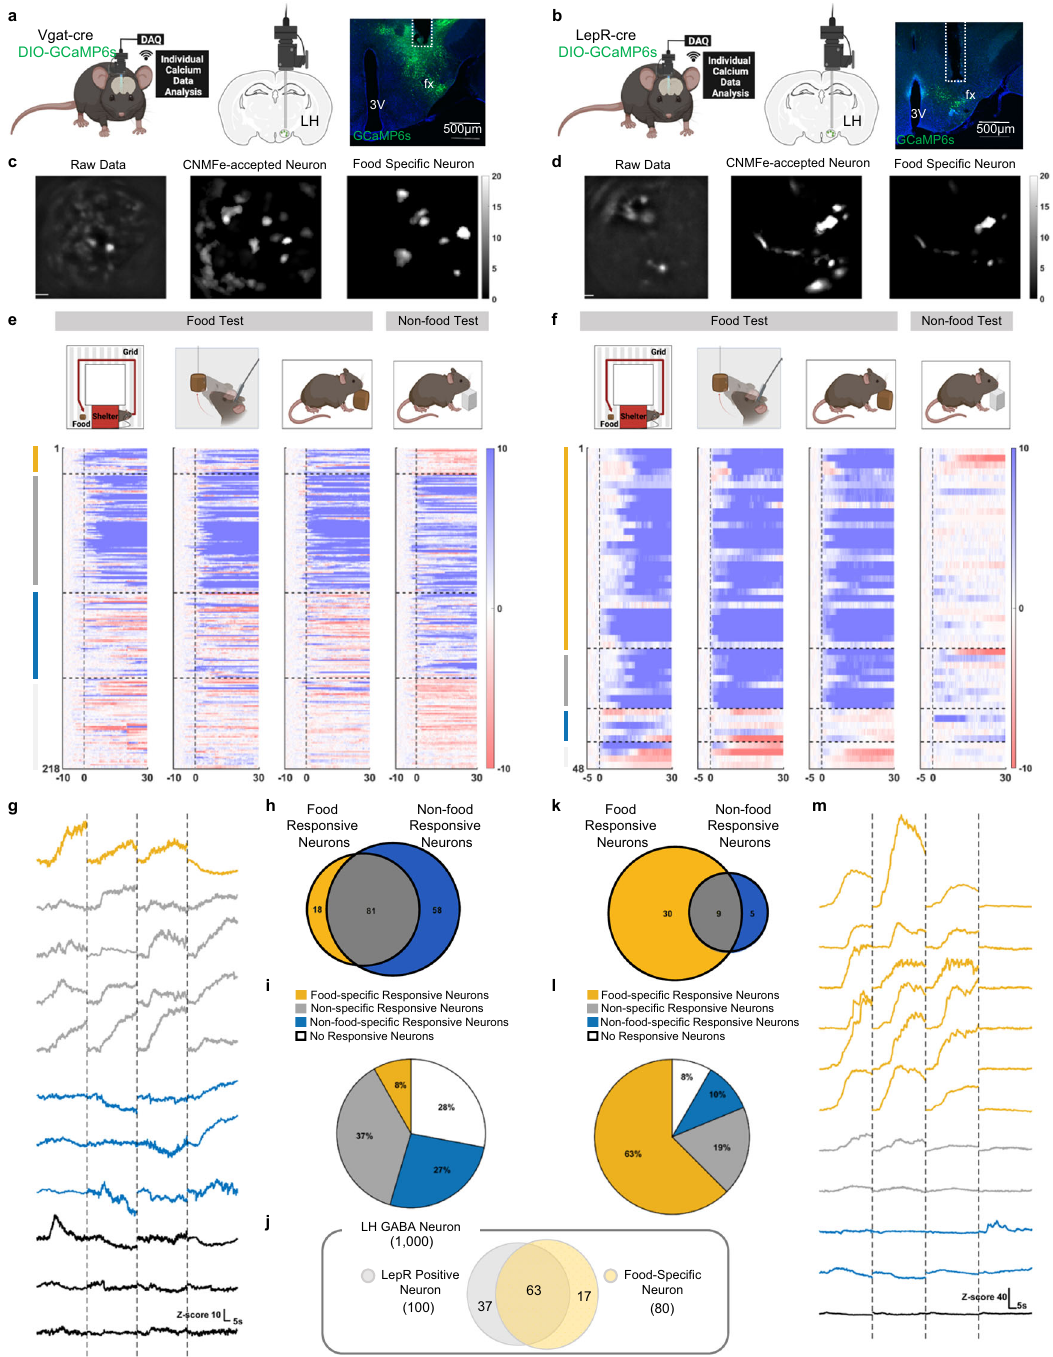
Fig. 1 | LH LepR neurons are the food-speci fi c subpopulation of LH GABA neurons. a , b Schematic of micro-endoscopic calcium imaging (left, middle), and image of GCaMP6sexpression(right)intheLHfromVgat-cre( a )andLepR-cremice( b ).The experiment was repeated 6 times ( a ) or 4 times ( b ) independently with similar results.fx,fornix;3V,the3rdventricle. c , d Spatialmapofrawdata(left),accepted cells using CNMFe (middle), and cells that only respond to food-related behaviour (right)fromLH GABA neurons( c )andLH LepR neurons( d ).Cellsarecolouredaccording to themaximum Z-score.Scale bar:50 μ m. e , f Schematicof the multi-phase test2, consummatory behaviour test 1, consummatory behaviour test 2 (food and non- food) (top). Heatmap depicting calcium signals aligned to the onset of feeding behaviours(runningtofood,rearingtofood,contactwithfood,contactwithedible object) (below). Four populations are discriminated: food-speci fi c responsive (yellow), non-speci fi c responsive (grey), non-food-speci fi c responsive (blue), and